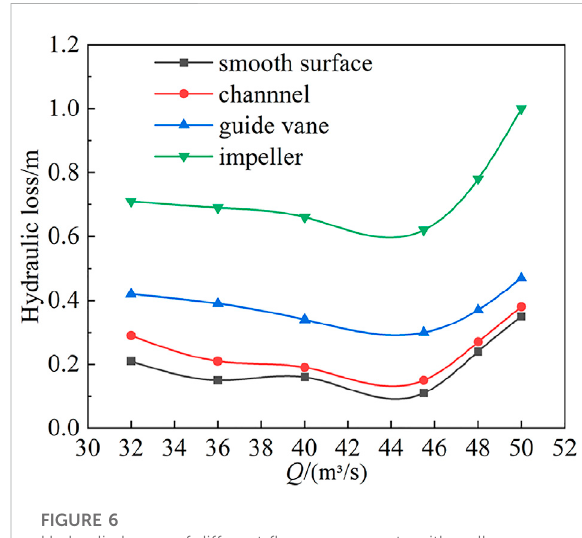
FIGURE 6 Hydraulic losses of different fl ow components with wall roughness.